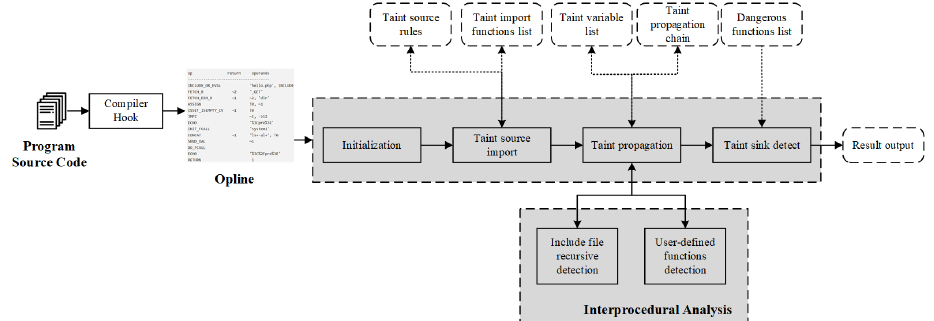
Figure 4 . The overview of static taint analysis in our